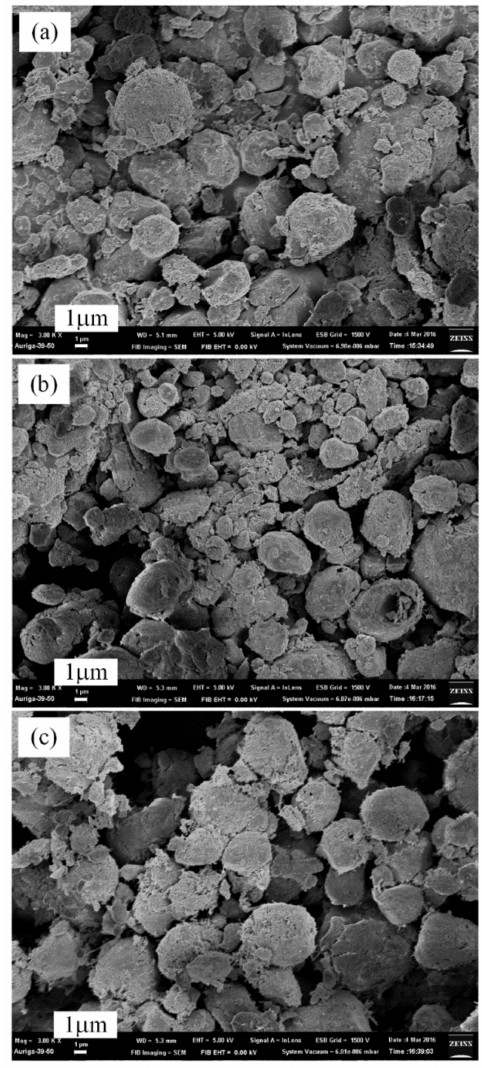
Figure 6. SEM micrographs (3000 × ) of pre-synthesized AlN/Al powders by plasma nitridation technique at 550 ◦ C for ( a ) 2 min, ( b ) 5 min, and ( c ) 10 min (Al/NH 4 Cl = 1:1, applied power: 1200